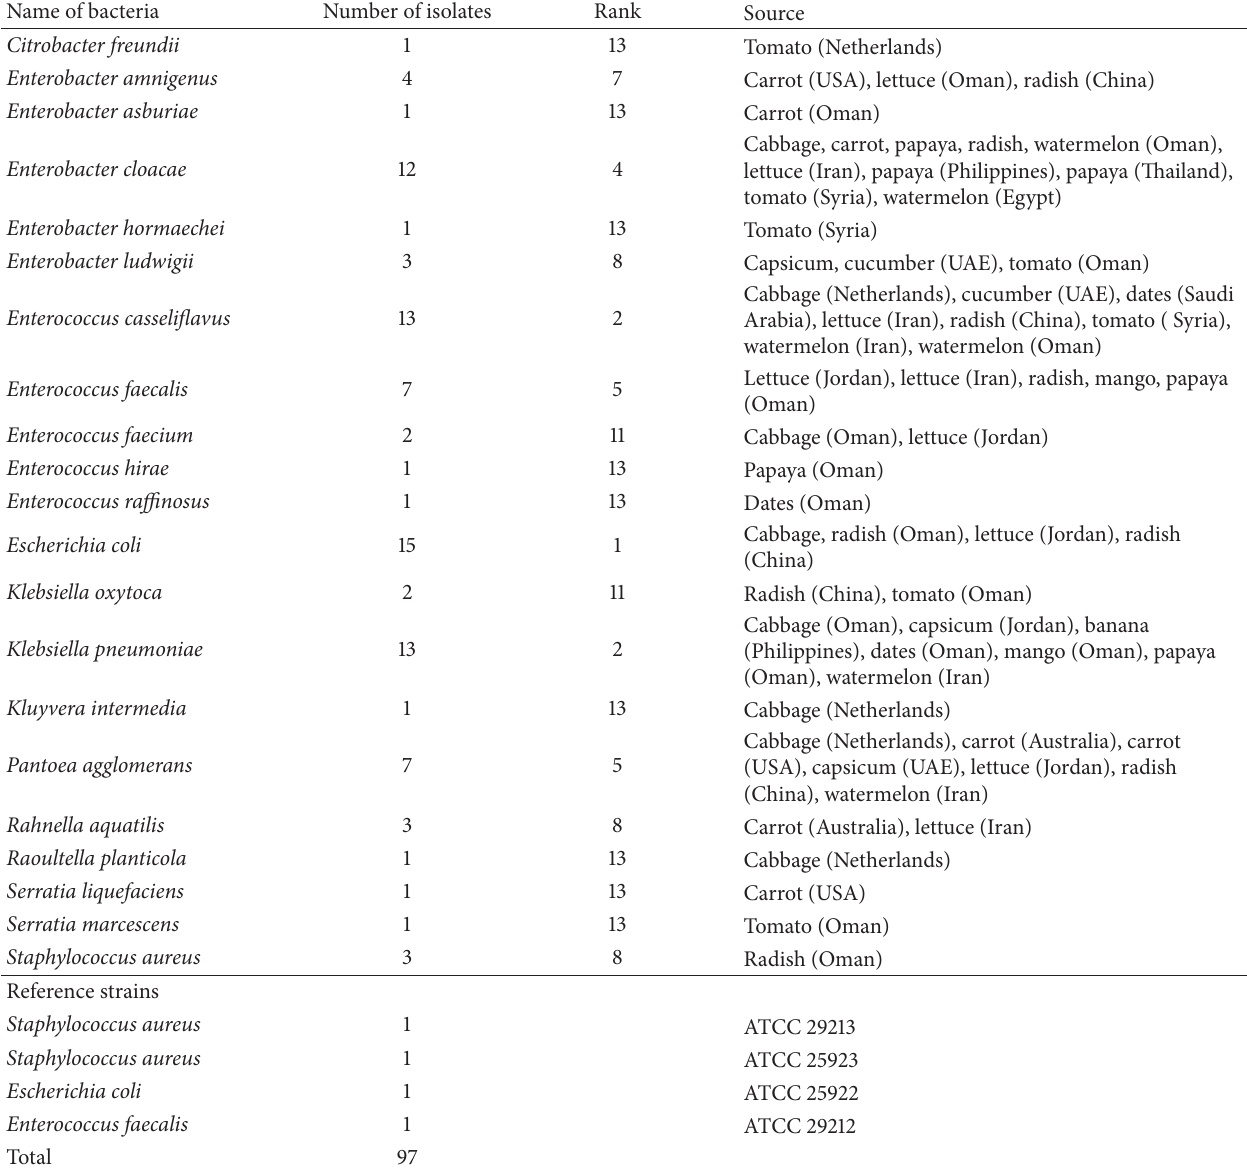
Table 2: Bacteria that were similarly identified to species level by VITEK 2 and PCR and their